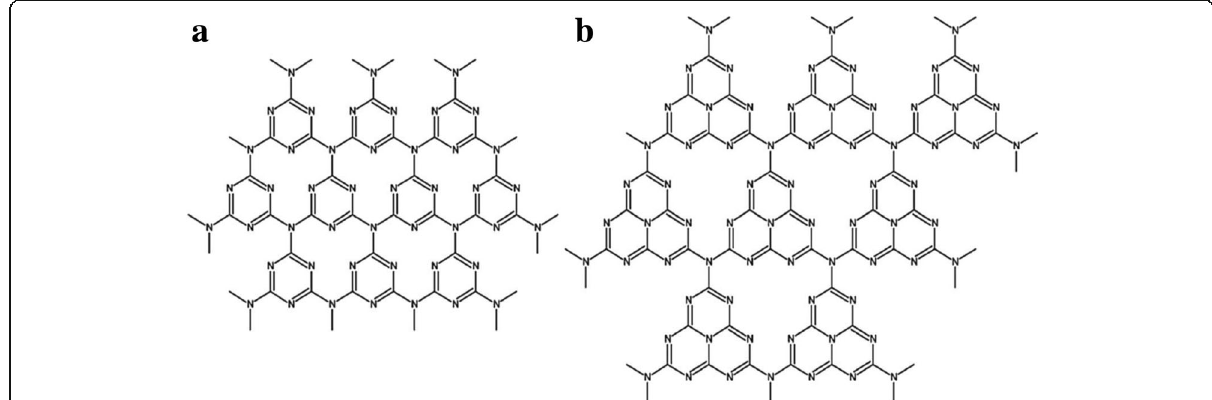
Fig. 3 a Tri-s-triazine and b tri-s- triazine as unit structures of g-C 3 N 4 . Reproduced with permission [25, 31]. Copyright 2008 Royal Society of